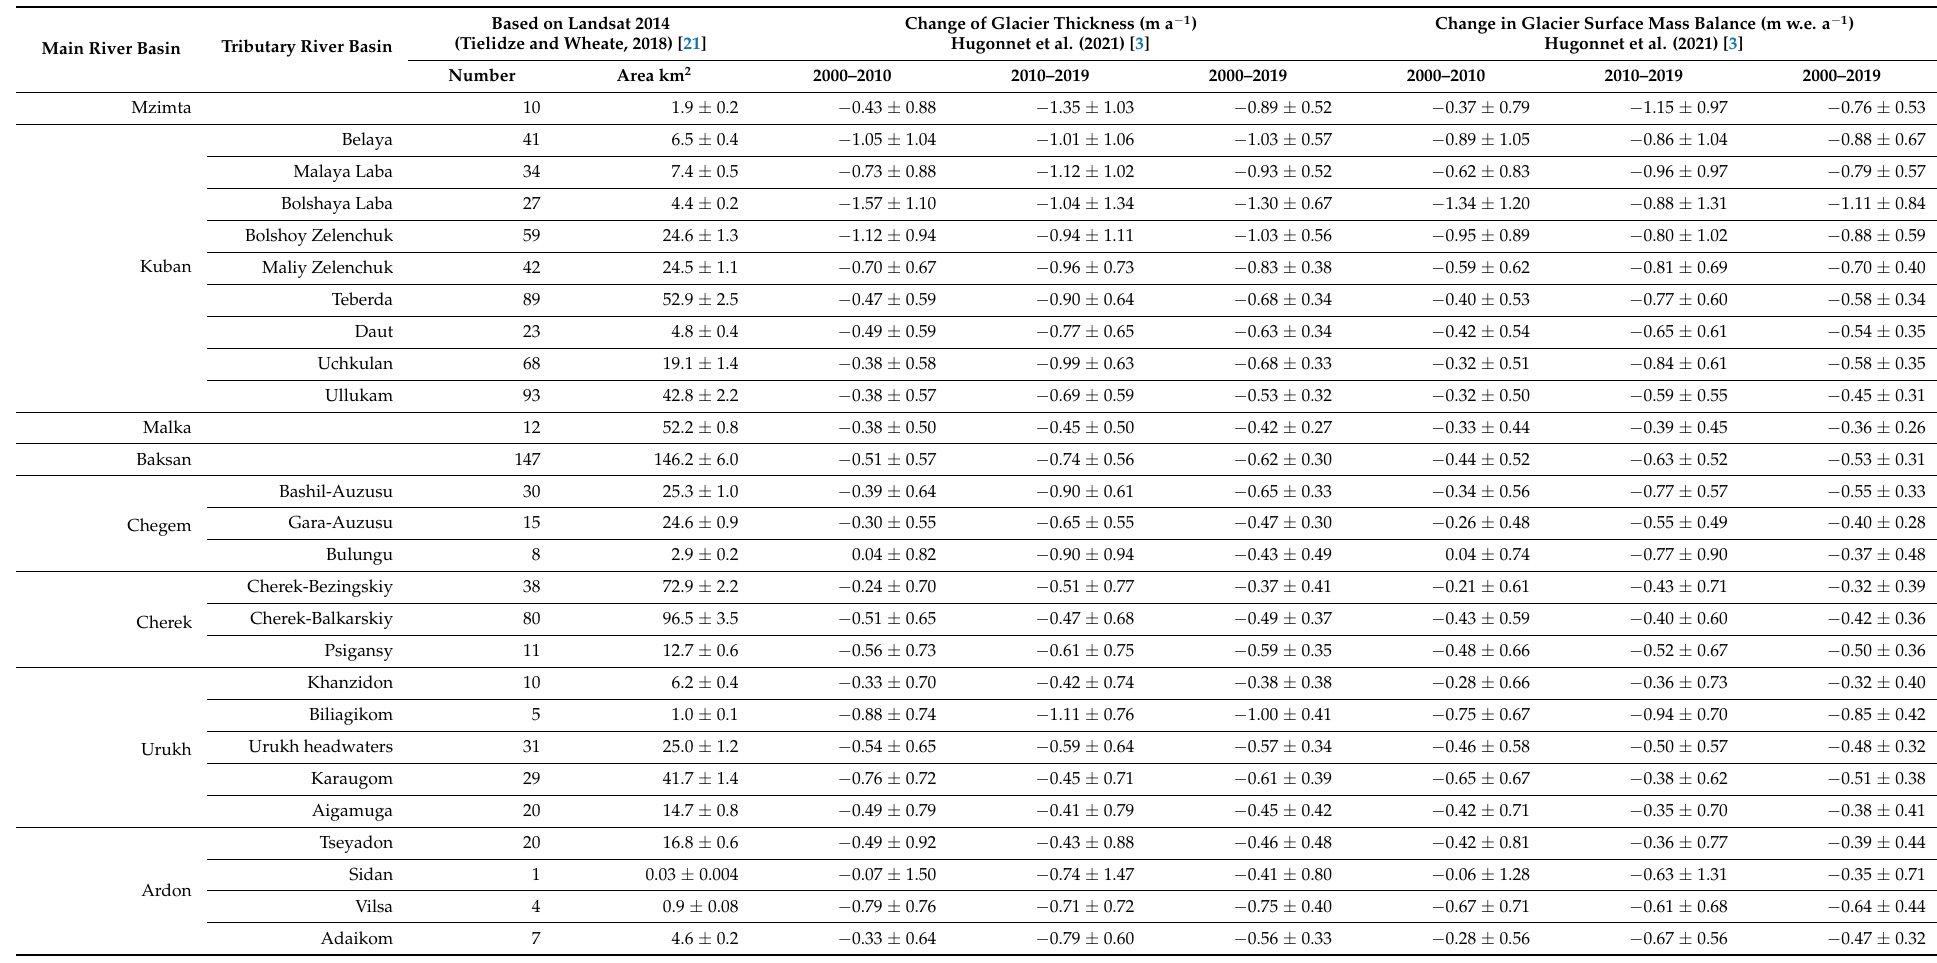
Table A1. Change in glacier thickness (m a − 1 ) and surface mass balance (m w.e. a − 1 ) for individual river basins of the Greater Caucasus in 2000–2010, 2010–2019, and 2000–2019. See also Figure 1 to check the location of all river basins relative to the Greater